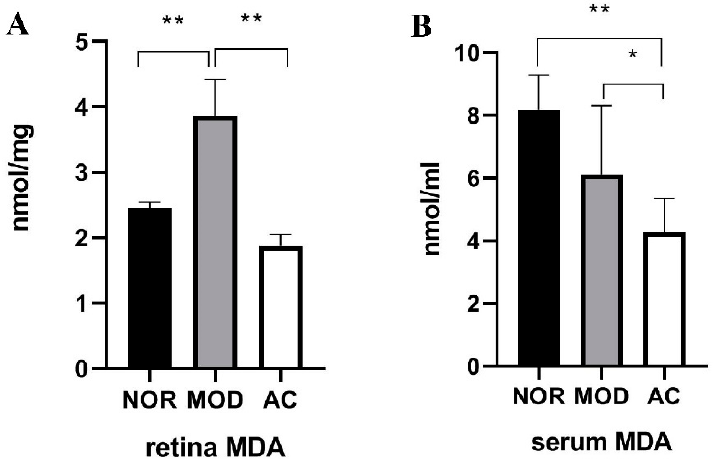
Figure 4. Malondialdehyde (MDA) levels in the retina ( A ) and serum ( B ) of rats. Data are the mean ± standard deviations ( n = 8). (*) p < 0.05, (**) p < 0.01 (one-way ANOVA followed by Tukey’s test).